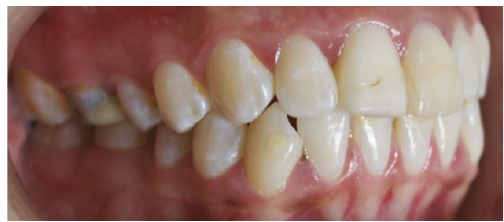
Figure 2: Relationship of crown height in occlusion with the antagonist tooth (side view).